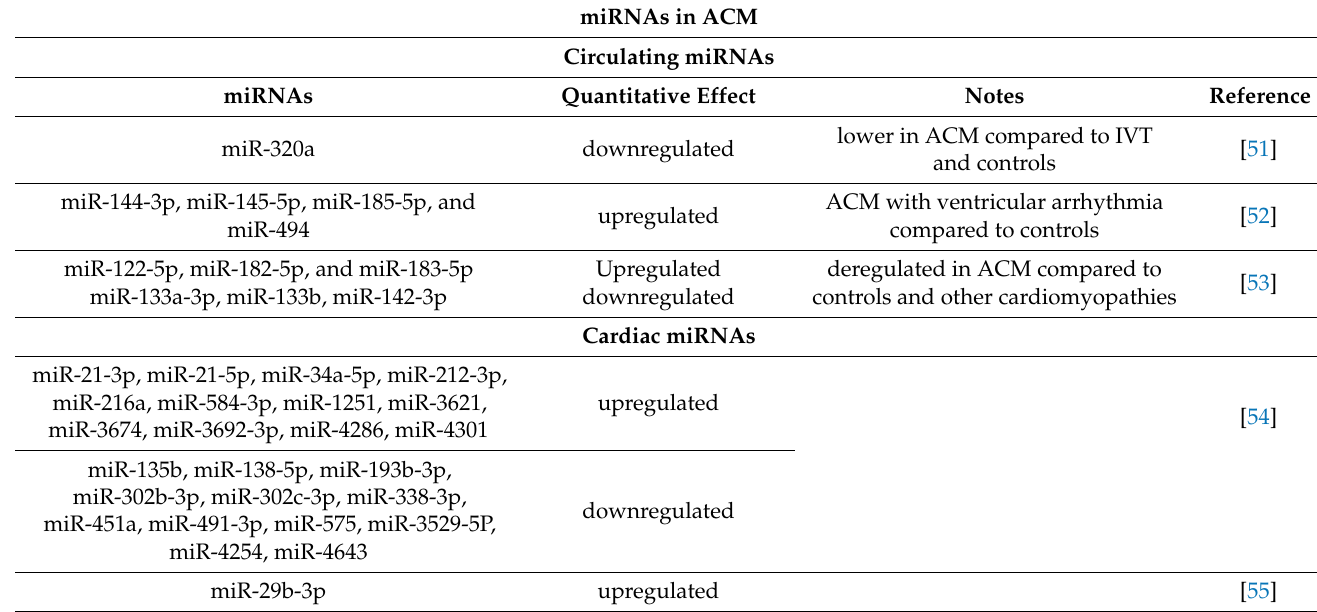
Table 2. Summary of miRNAs potentially involved in human